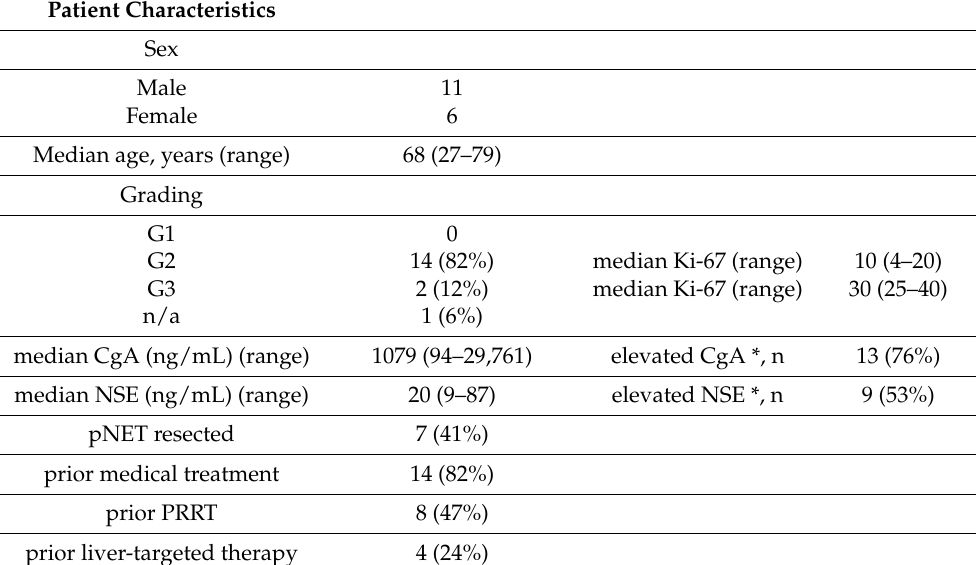
Table 1. Patient